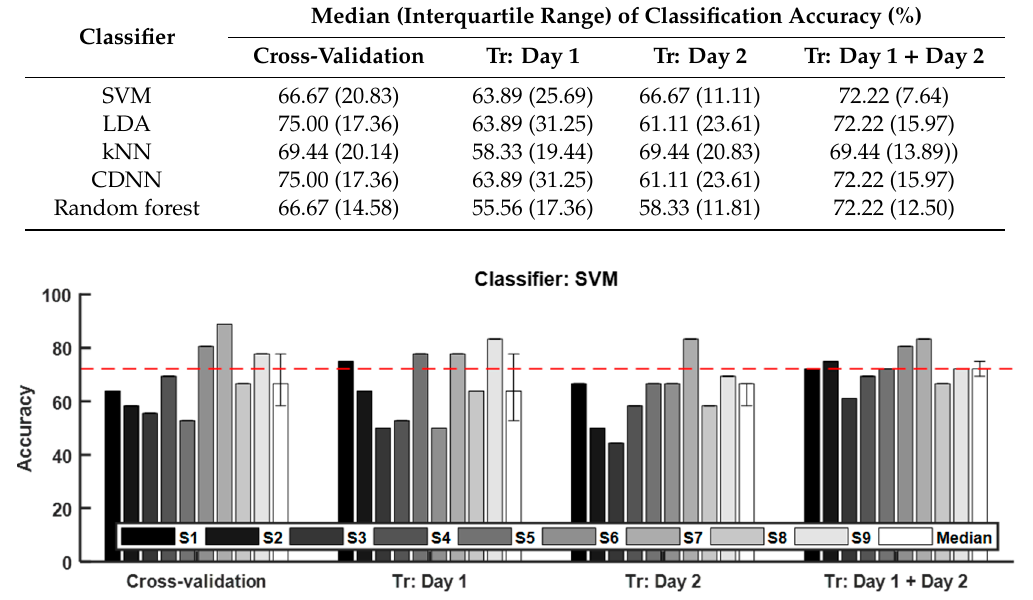
Figure 2. Accuracy in classifying craving states using multimodal biosignals measured during “Day 3” experiments. “Cross-validation” represents the 6-fold cross validation using the “Day 3” data. “Tr: Day 1” implies that the “Day 1” dataset was used as training data. “Tr: Day 2” implies that “Day 2” dataset was used as training data. “Tr: Day 1 + Day 2” implies that both “Day 1” and “Day 2” datasets were simultaneously used as training data. The error bars of median accuracies indicate the first and third quartile of the classification accuracies of all subjects. The red dashed line represents the median classification accuracy for “Tr: Day 1 + Day 2”.